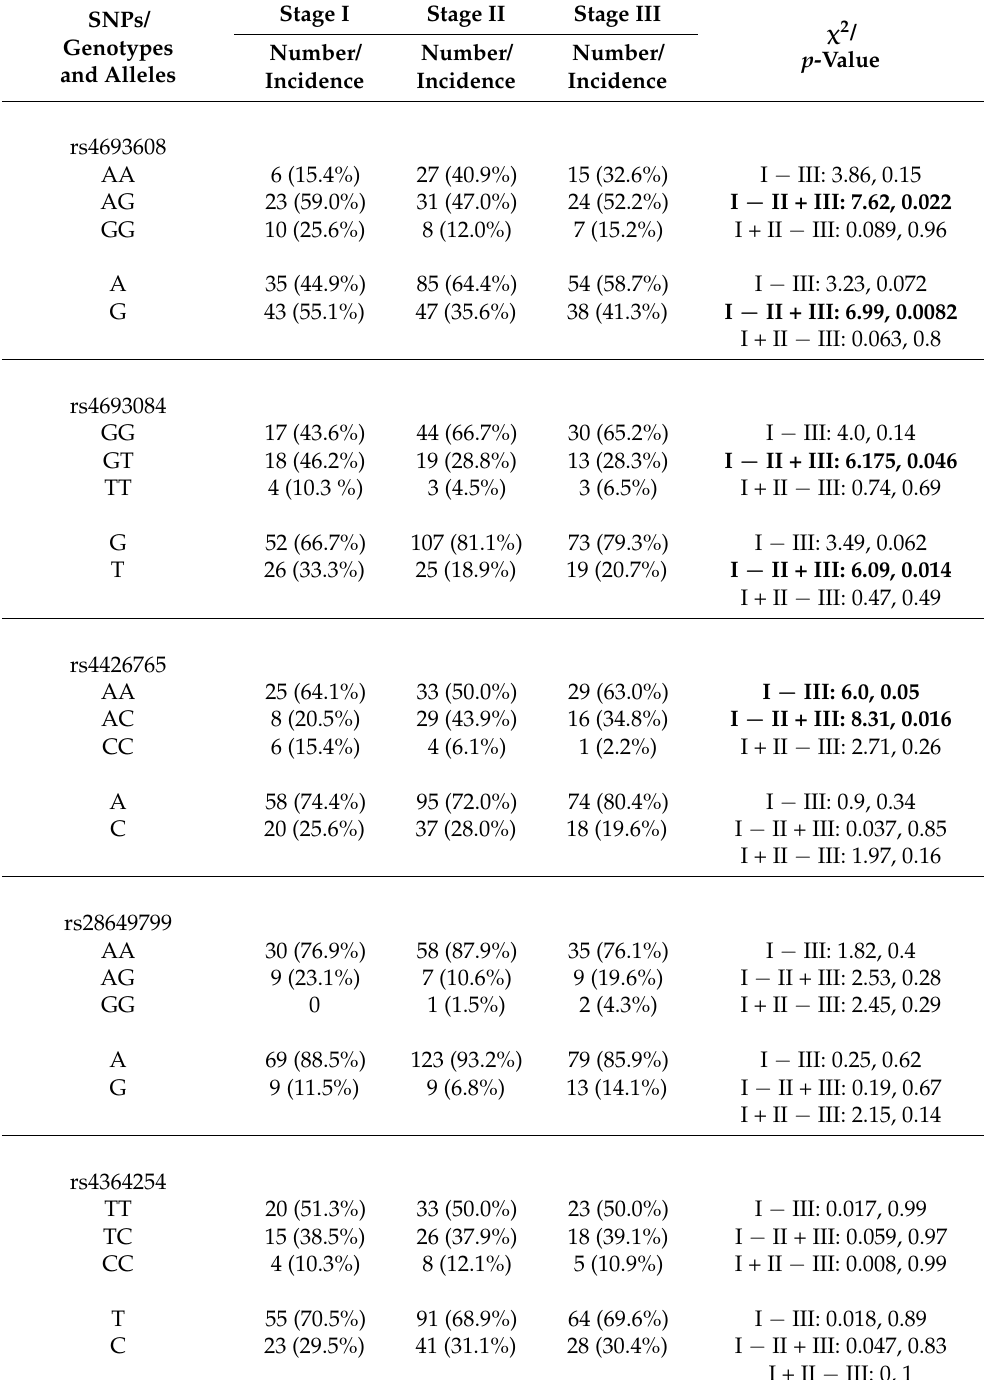
Table 2. Genotype and allele frequencies of the HPSE gene SNPs according to the International Staging System (ISS) in multiple myeloma